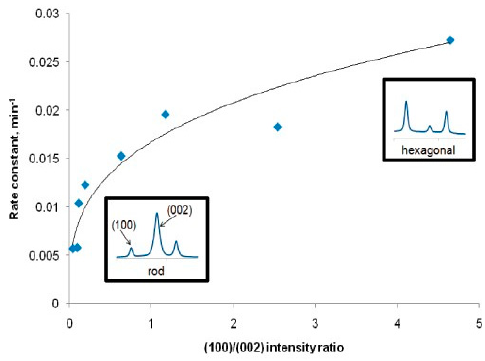
Figure 7. Plot of the rate constants vs (100)/(002) intensity ratio. Reproduced with permission from [171]. Copyright American Chemical Society, 2009.